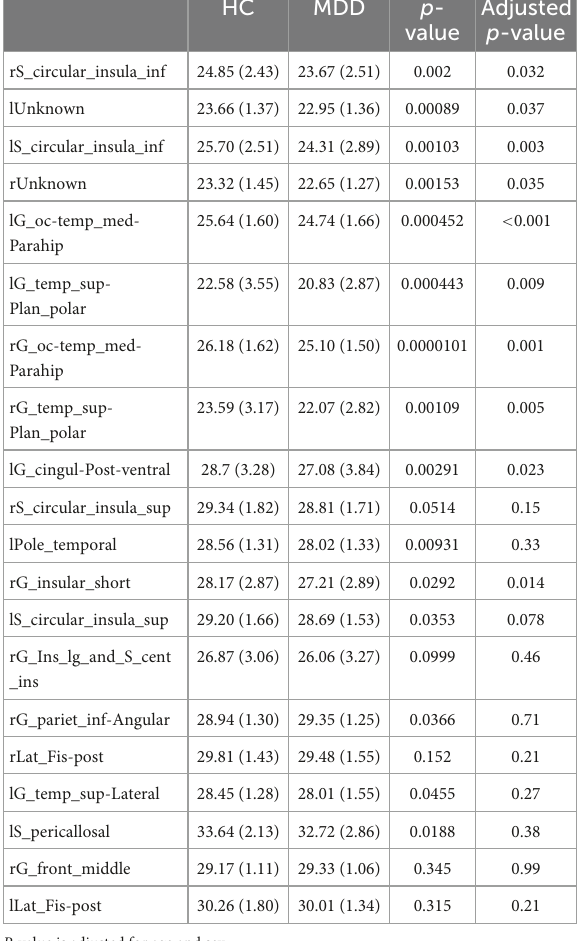
TABLE 2 Top 20 gyrification patterns (VIP > 1.5) in major depressive disorder (MDD) and healthy control (HC) groups. HC